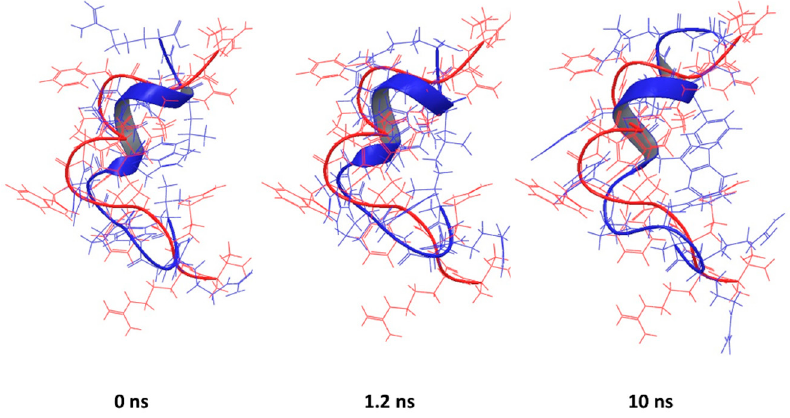
Figure 6. Backbone superposition of PDB entry 1D6X (red) and simulated conformations at 0, 1.2 and 10 ns (blue). No significant change was observed over the simulation time, with a slight improvement at 1.2 ns.